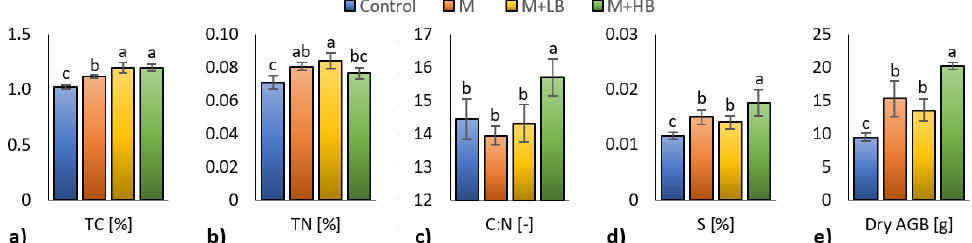
Mean values calculated as average from independent replicates ( n = 4) ± SD (standard deviation). * Different letters express the statistical differences at the significance level p ≤ 0.05.